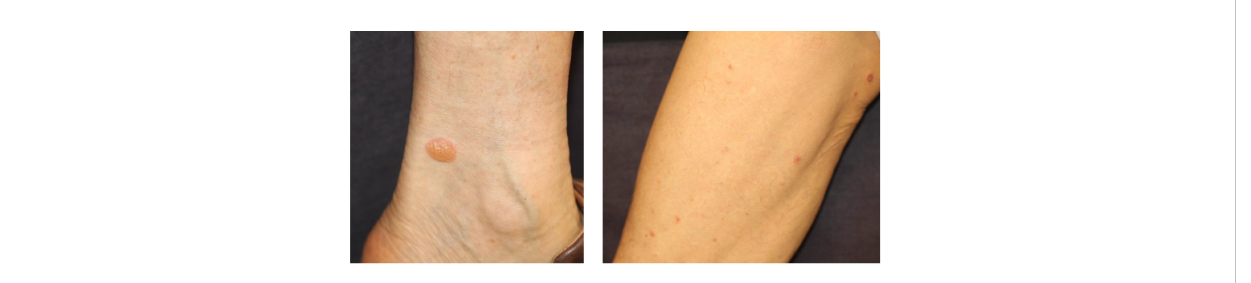
FIGURE 2 Bullous pemphigoid eruption. Multiple small tense bullae on extremities. Written informed consent was obtained from the individual(s) for the publication of any identi fi able images or data included in this